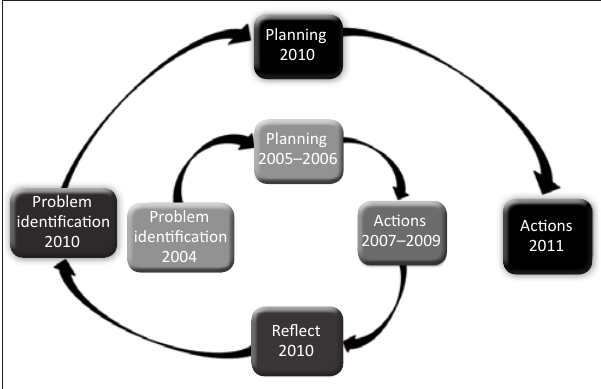
FIGURE 1: Serial cycles of action